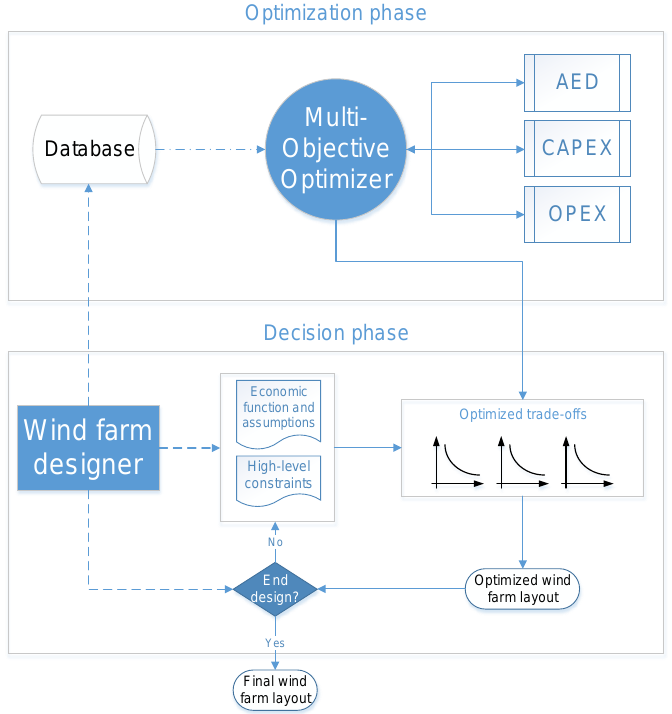
Figure 5. Proposed MO optimization framework for the design of OWFs and their electrical infrastructure. Dotted-line arrows represent input from the designer, solid-line arrows represent algorithm flow and dotted-point-line arrows represent component